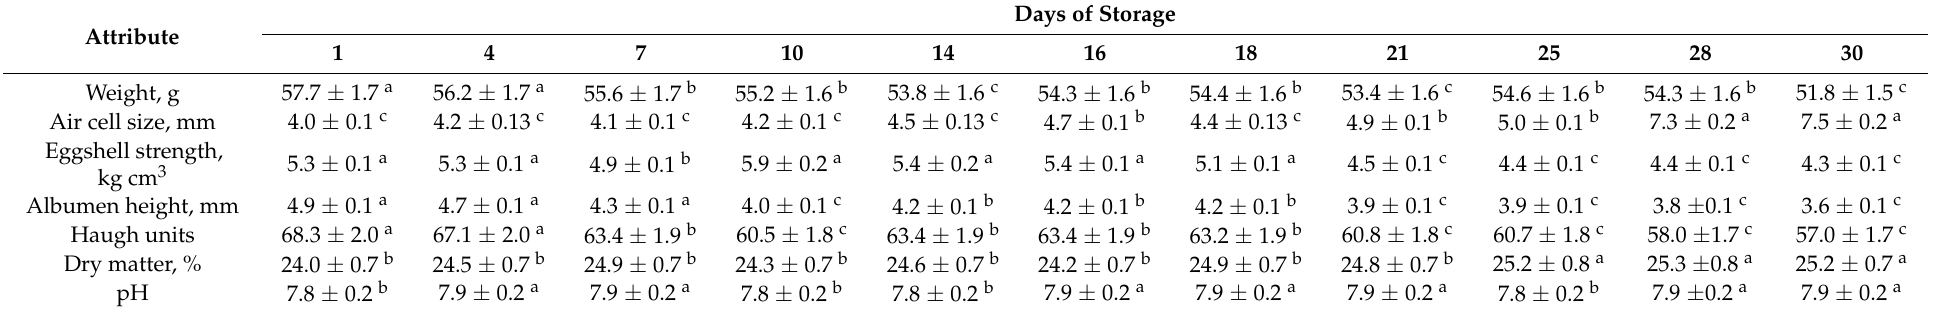
Table 1. Changes in egg physical attributes during storage period of 30